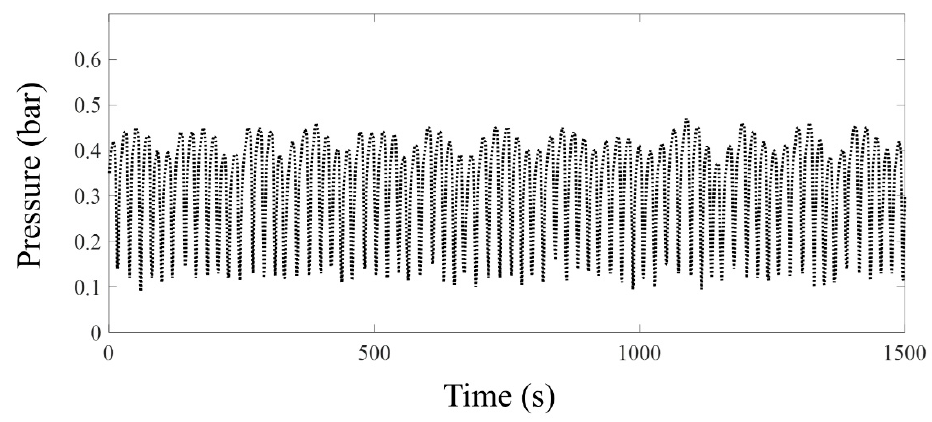
Figure 2. Typical pressure signal near the riser base of DFSS. The water and gas superficial velocities are u SW = 0.15 m / s and u SG = 0.99 m / s, respectively. The period of the high-frequency element is approximately 20 s, and that of low-frequency part is roughly 100 s.